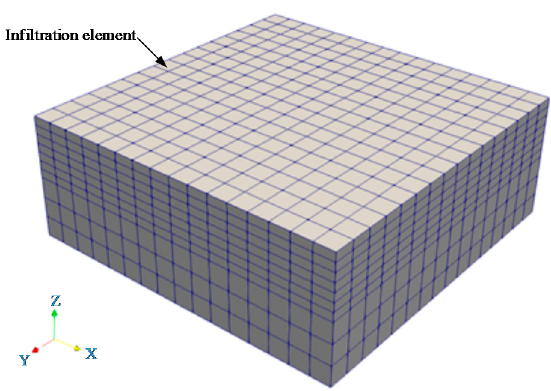
Figure 4. Numerical model for infiltration.